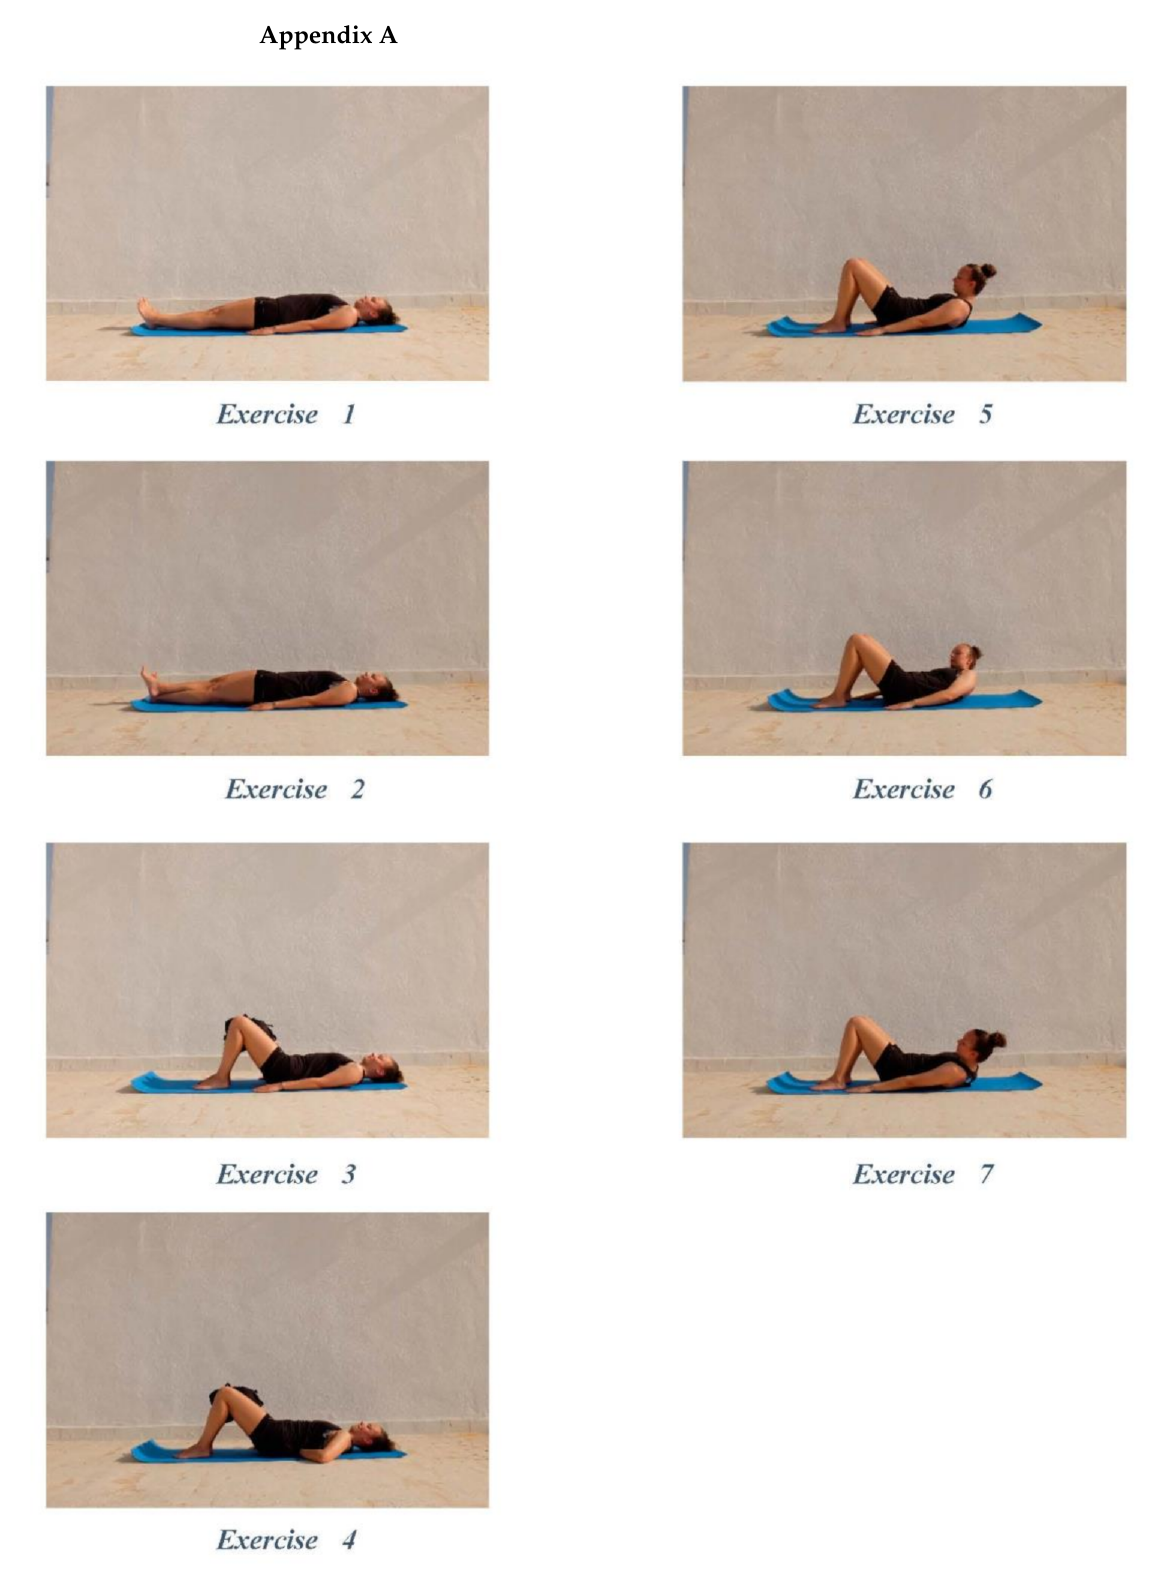
Figure A1. Isometric Exercises